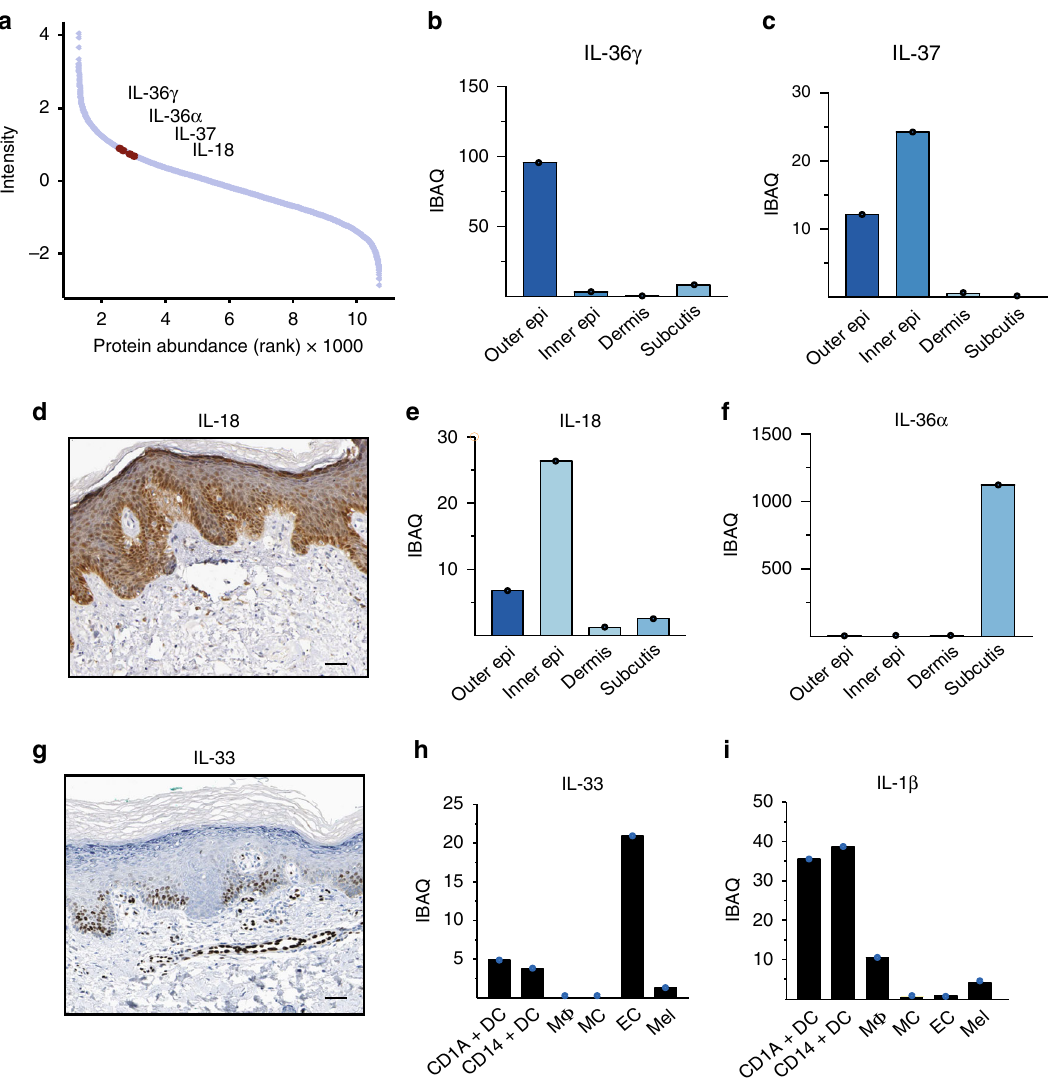
Fig. 3 Expression levels of interleukin 1 family members in the skin. a Dynamic range plot illustrating the abundance of interleukin (IL) 1 family members in the skin. b , c Estimated intensity of the IL-1 family members IL-36 γ and IL-37 throughout the skin. IL-36 γ is primarily found to be expressed in the outer epidermal layer whereas IL-37 is both found to be expressed in the outer- and inner epidermal layer. d Immunohistochemical staining of healthy skin obtained from the Human Protein Atlas (Methods, Supplementary Data 17) showing IL-18 protein expression primarily in the inner epidermal layer (dark brown), scale bar: 50 µ m. e , f Estimated intensity of the IL-1 family members IL-18 and IL-36 α throughout the skin. IL-18 is mainly found in the inner- and outer epidermis whereas IL-36 α is found in subcutis. g Immunohistochemical staining of IL-33 expression on healthy skin obtained from the Human Protein Atlas (Methods, Supplementary Data 17), scale bar: 50 µ m. h Estimated intensity of recently discovered IL-33, here depicted in FACS-sorted skin-derived endothelial cells (EC), and to lesser extent in macrophages (M Φ ) and dendritic cells (DC). i Estimated intensity of IL-1 β expression in FACS-sorted cellular subsets from healthy skin. All barplots show estimated intensity (IBAQ, log2) based on one library of pooled samples ( N = number of pooled samples) of skin layers ( N = 5; b , c , e , f ), CD1A + dendritic cells ( N = 3; h, i), CD14 + dendritic cells ( N = 3; h, i), M Φ ; macrophages ( N = 4; h , i ), mast cells ( N = 6; h , i